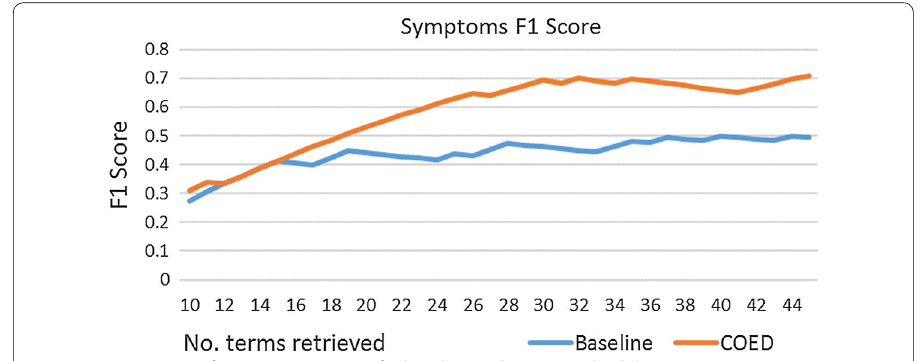
Fig. 11 Comparison of symptoms F1 score for baseline and COED